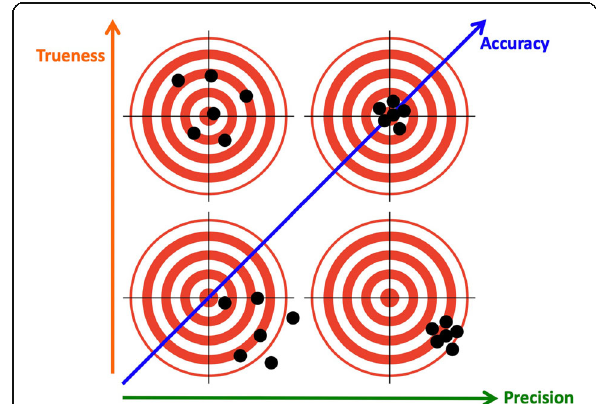
Fig. 1 Conceptual image of the relationship between trueness, precision, and accuracy, as defined by ISO (1994). The centre of the target represents the “ true value ” provided by the reference data. The black dots represent test data obtained by repeated measurements. ISO, International Standard